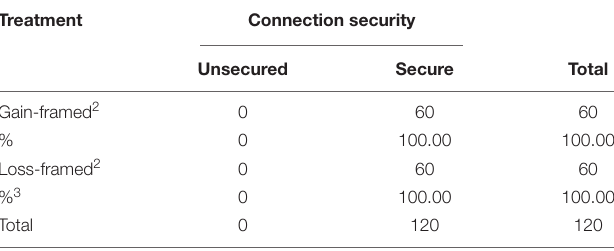
TABLE 3 | Decision 1 – choosing a secure connection by treatment 1